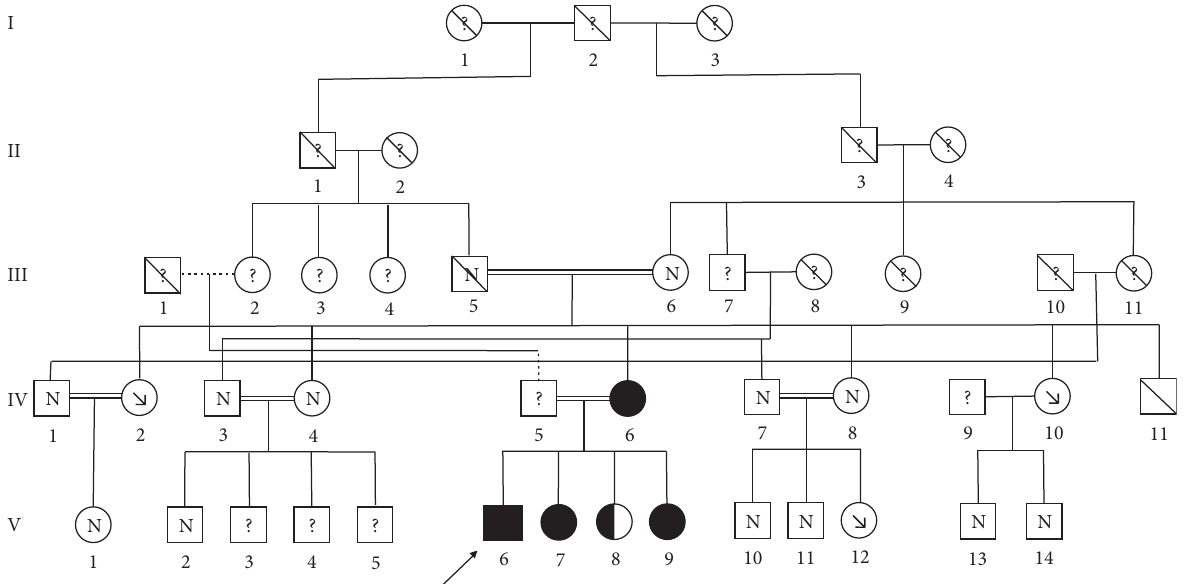
Figure 1: Pedigree of the patient. Solid symbols denote family members with homozygous mutation; half-solid denote heterozygous mutation. “N” denotes family members with normal uric acid level; “ ↘ ” denotes severe hypouricemia. “?” denotes family members with no laboratory data. Circles represent female family members, squares represent male family members, and crosses represent dead family members. Double lines indicate consanguineous marriage. Arrow indicates the index